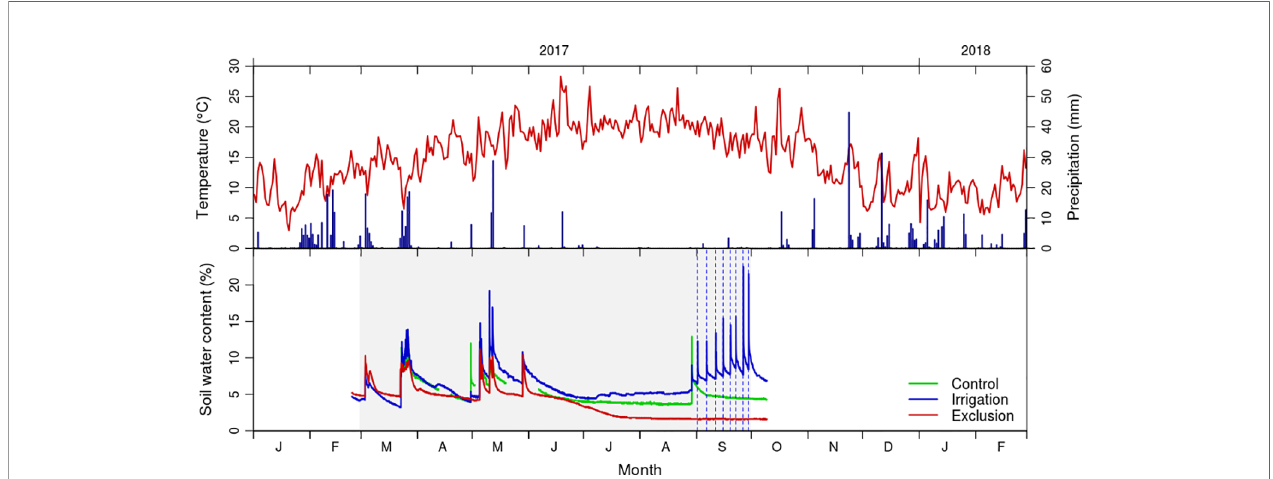
FIGURE 1 | Daily values of mean temperature (°C) and total precipitation (mm) from January 2017 to March 2018 registered by the Figueira da Foz meteorological station (data from Instituto Português do Mar e da Atmosfera); and soil moisture content (volume/volume) in control (green line), exclusion (red line) and irrigation (blue line) treatment. Gray shaded area corresponds to the rain exclusion period and vertical dashed lines to the irrigation